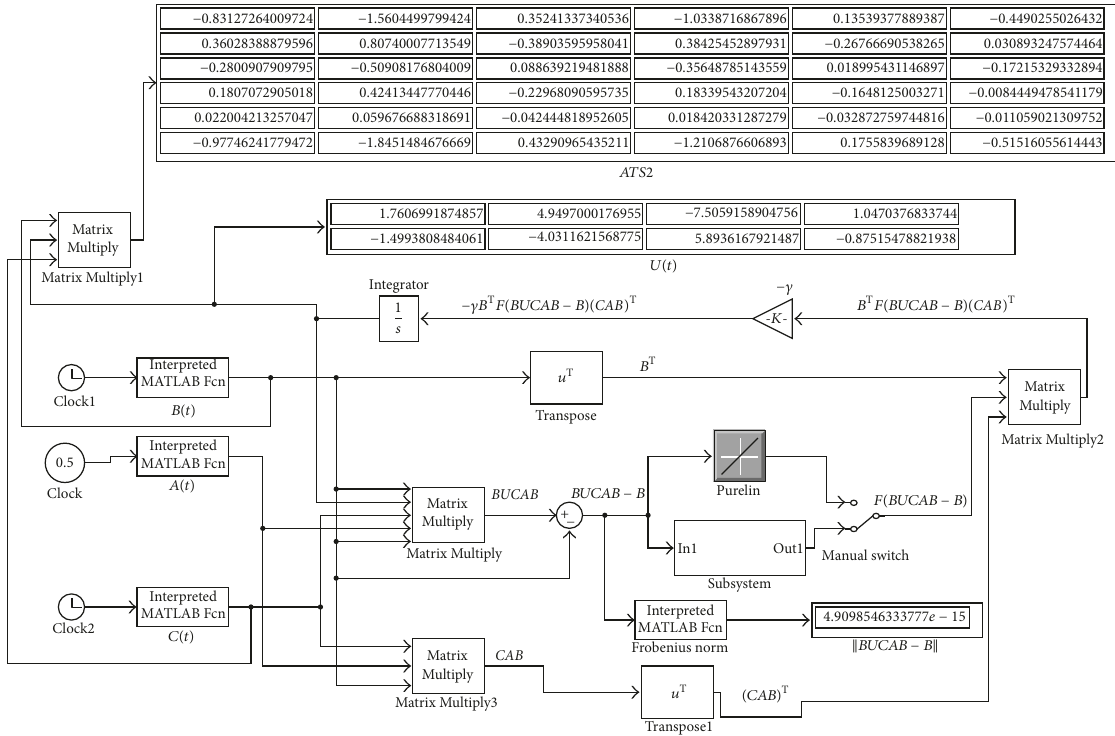
Algorithm 2: Computing an outer inverse with the prescribed null space.